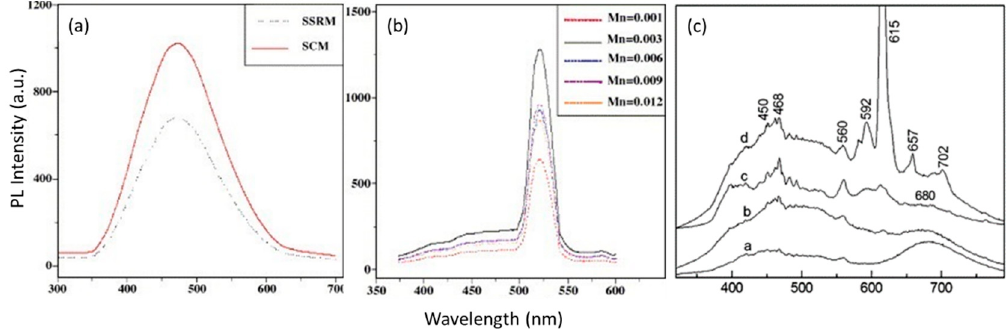
Figure 25. ( a ) Emission spectra of ZnGa 2 O 4 ; ( b ) emission spectra of Zn 1-x Mn x Ga 2 O 4 with different